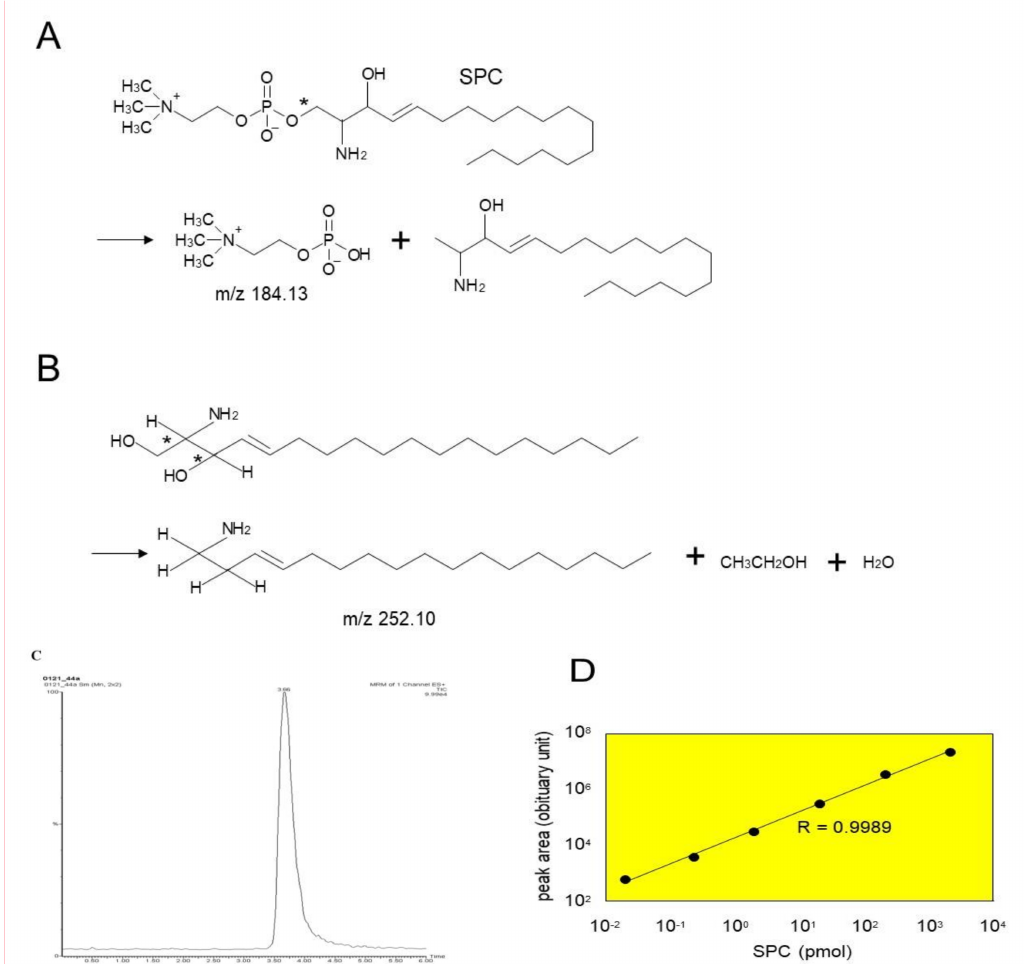
Figure 9. Quantification of the reaction product of SM deacylase (SPC) by LC-MS / MS. ( A ) Molecular structure of SPC and the predicted MS / MS fragments. SPC was fragmented into two parts at the site indicated by the asterisk. The fragment of m / z 184.13 was detected to calculate the amount of SPC. ( B ) Structure of SPH shown with asterisks that indicate collision sites by MS / MS. The fragment of m / z 252.10 was detected to calculate the amount of SPH. ( C ) LC-MS / MS chromatograms of the MS / MS fragment of SPC. SPC (20 pmol) was injected into the LC-MS / MS and analyzed according to the method described in the Materials and Methods. ( D ) Standard curve prepared with di ff erent amounts of SPC; the peak areas were plotted against 0.02–2000 µ M